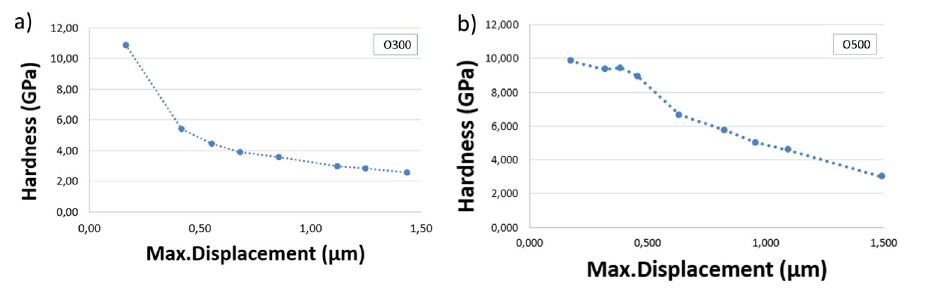
Figure 8. Surface hardness results of oxide layers obtained through Berkovich diamond nanoindenter: a) samples O300-2h and b) samples